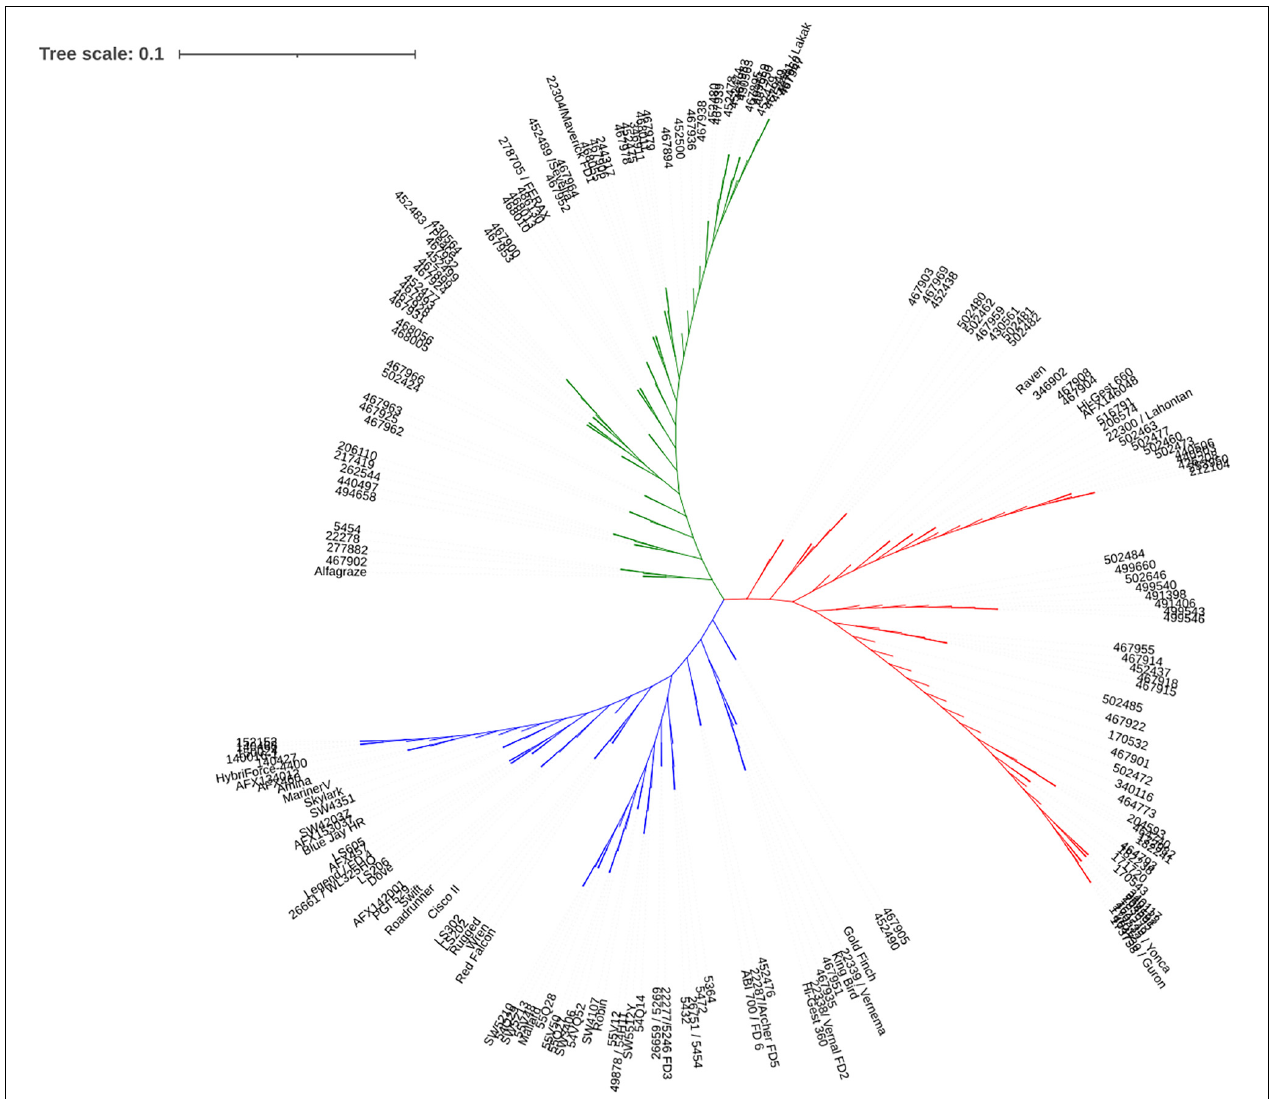
FIGURE 3 | Population structure based on phylogenetic analysis. Clusters 1, 2, and 3 were displayed in green, red, and blue,